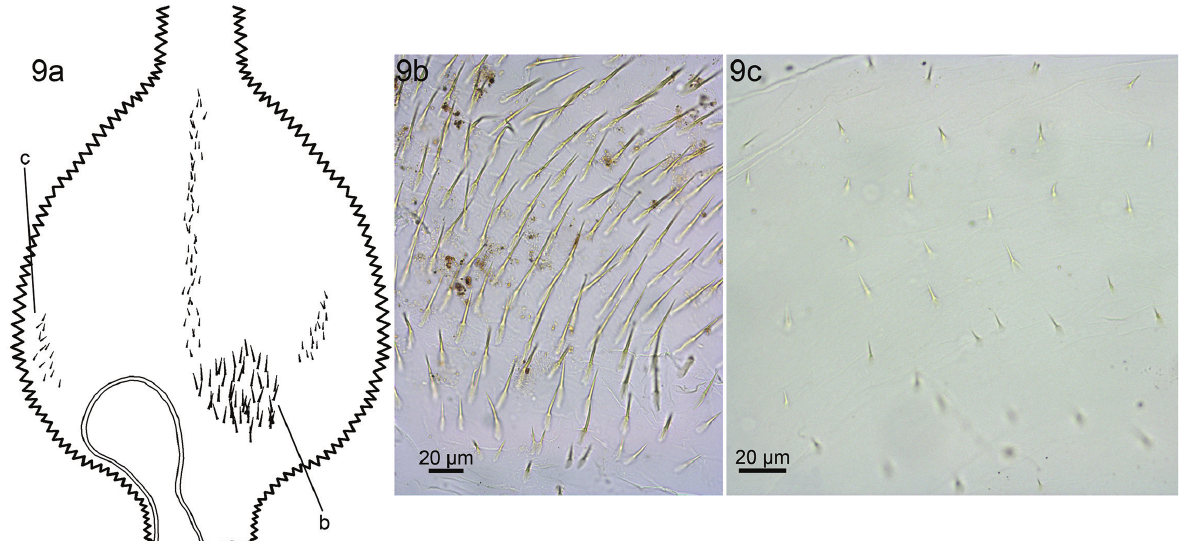
Figure 9. Embiratermes silvestrii . (a) Schematic drawing of P1 showing arrangement of spines. (b, c) Photomicrographs: (b) Set of aciculiform spines in detail; (c) Spines of the distal branches in detail.